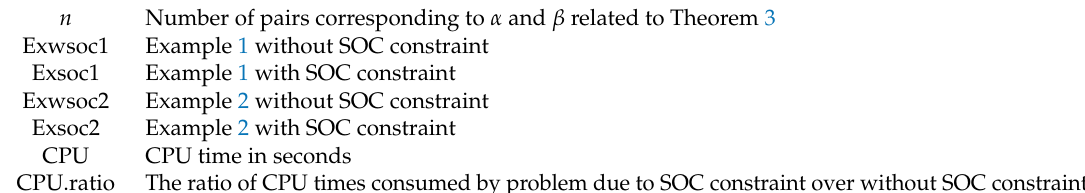
Table 1. Notations.